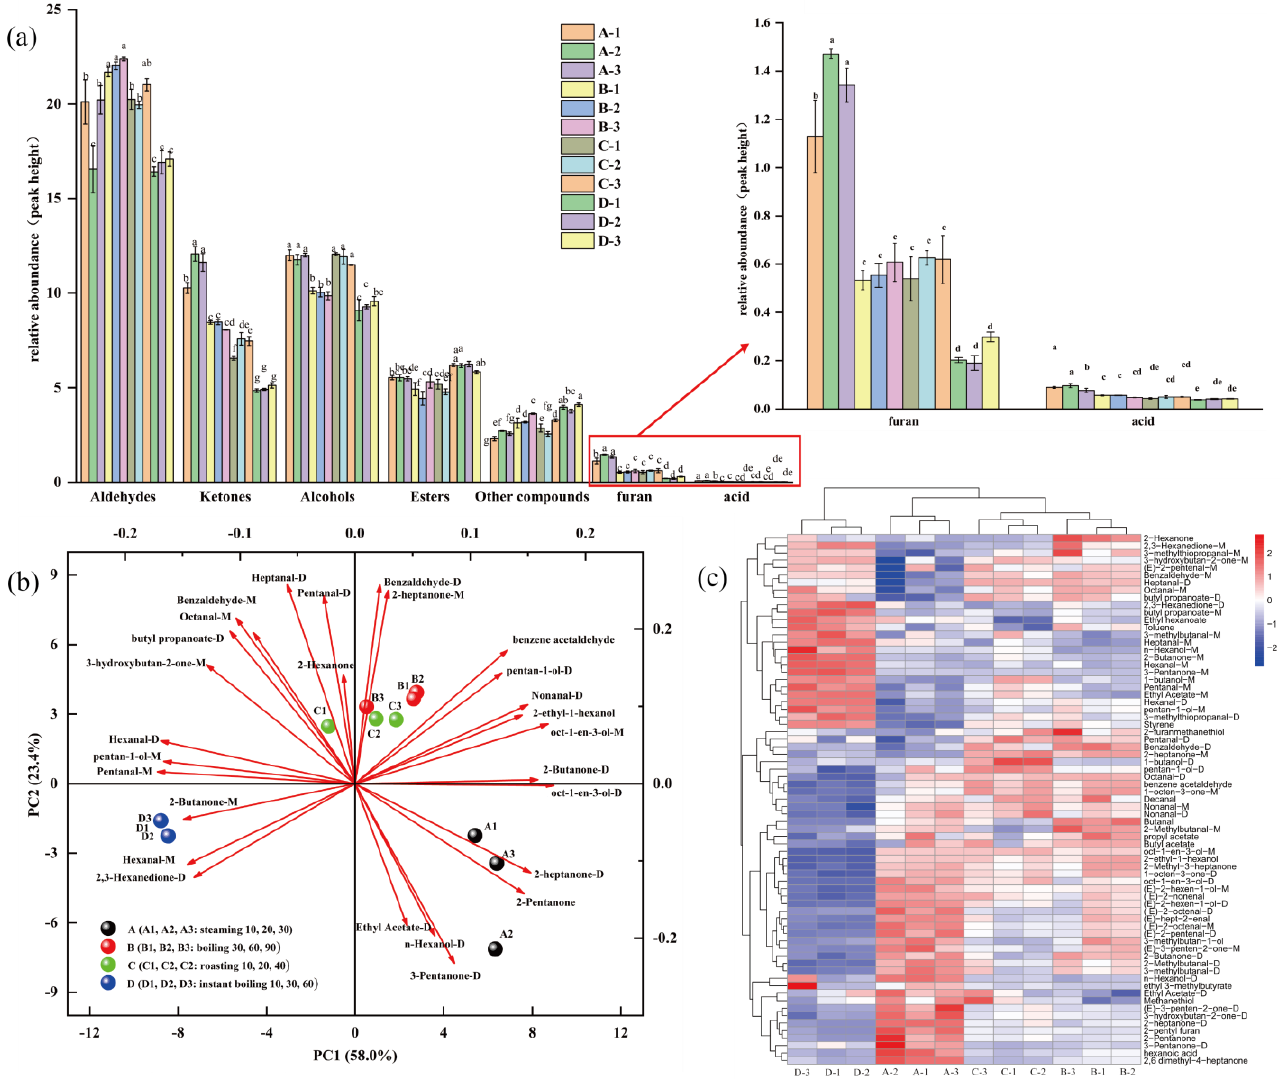
Figure 3. ( a ) Changes in the abundance of volatile components in Pingliang red beef under 12 different cooking methods. Different letters (a–g) in bars for different samples indicate significant differences ( p < 0.05). ( b ) Principal component analysis of Pingliang red beef samples from different cooking samples. ( c ) Heat map visualization and clustering results of the volatile compounds in beef